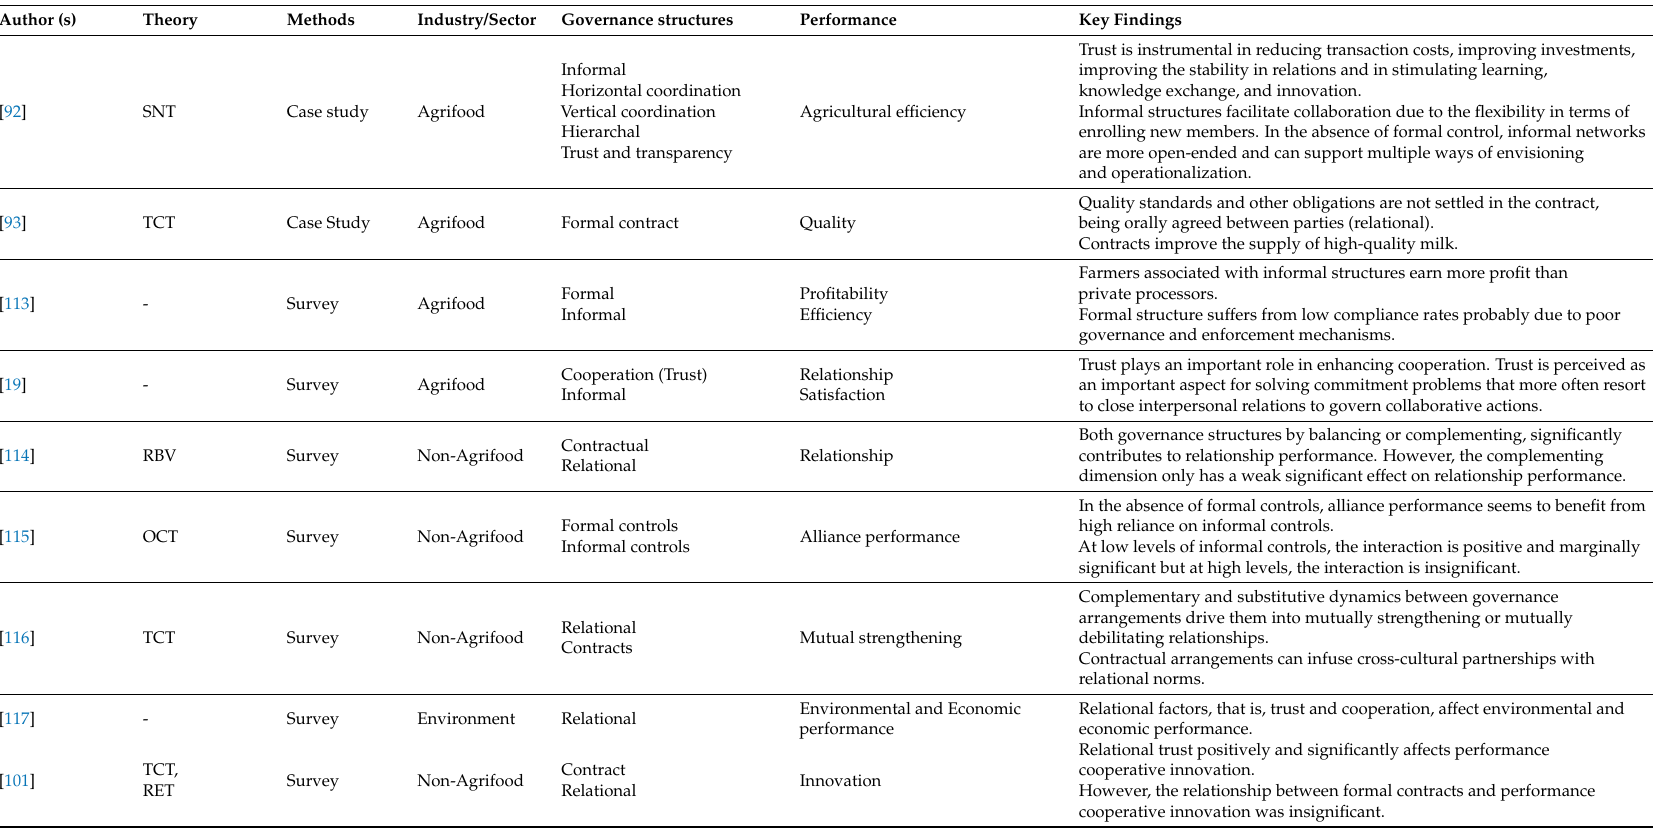
Table 4. The summary of the key findings on the relationship between governance structures and